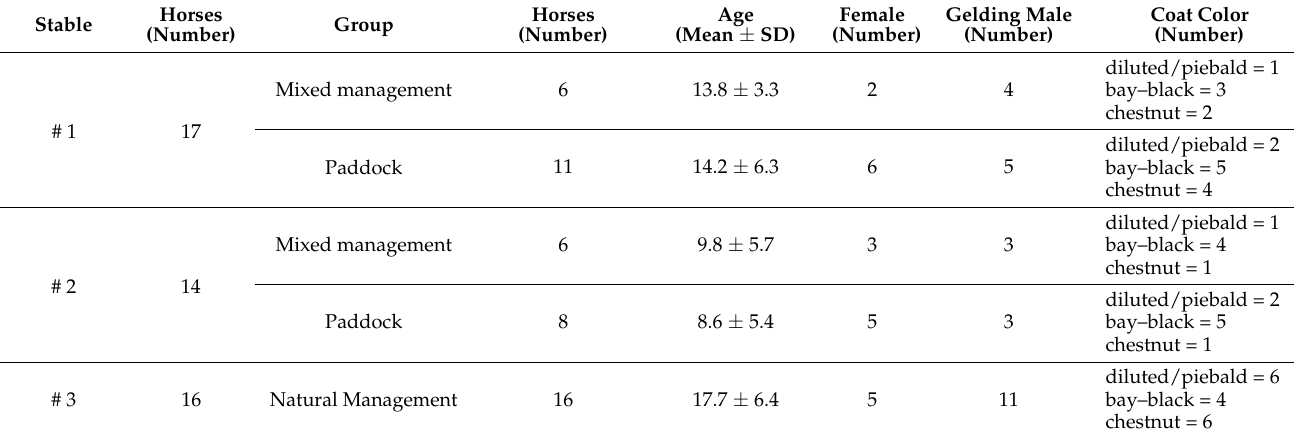
Table 1. Scheme of the horses involved in the study and group